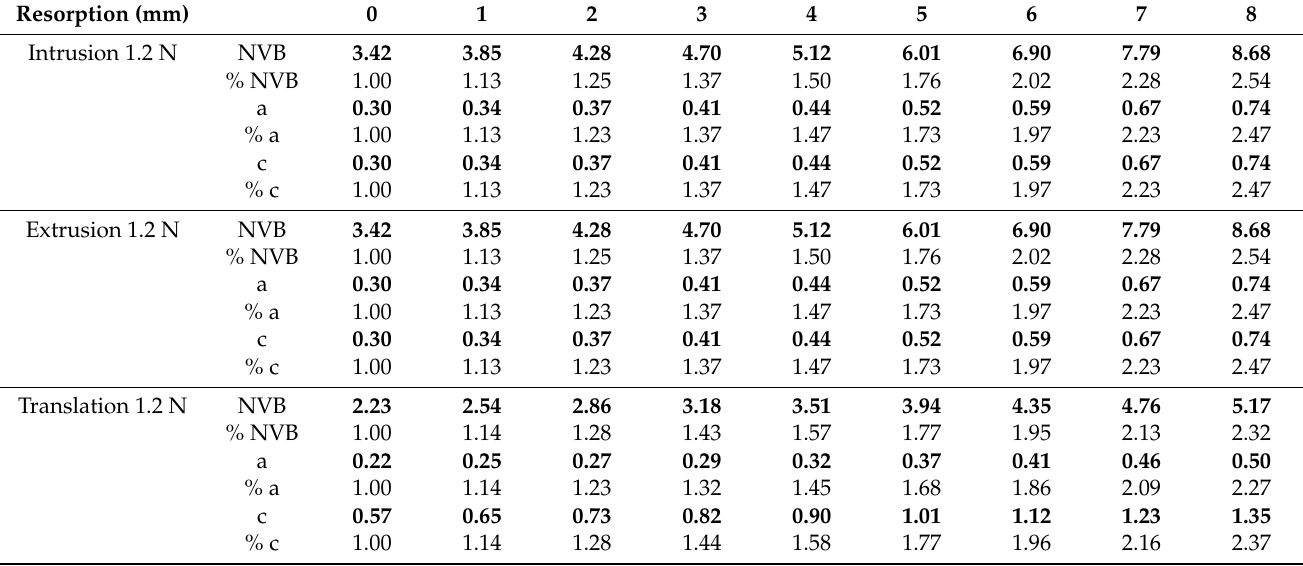
Table 3. The Tresca shear-stress average values (KPa) produced by 1.2 N of orthodontic